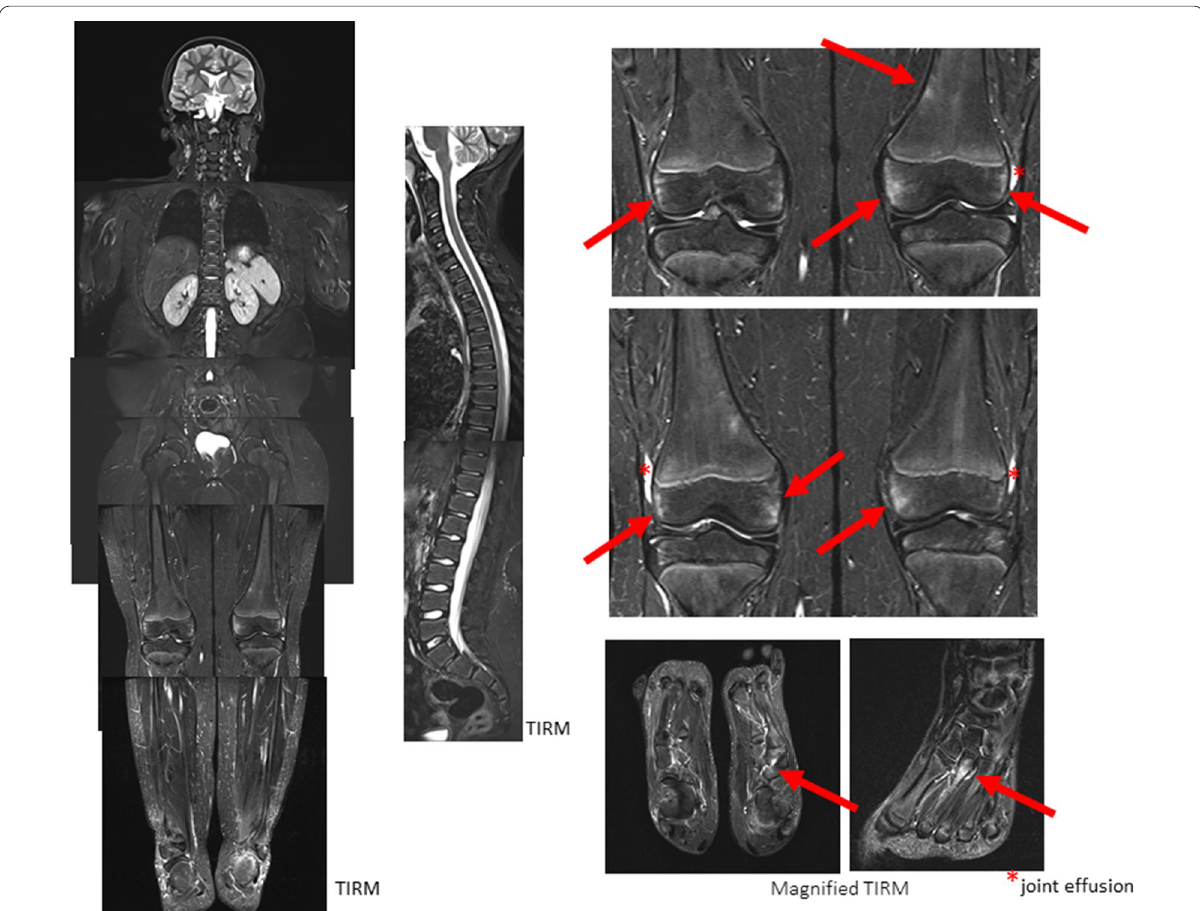
Fig. 3 An 11-year-old boy also without previous history of MSK pathologies and pain at multiple body regions (lower extremities, especially knees and feet). MRI shows bone marrow edema—more subtle than in Fig. 1, affecting the long bones (with focus on epiphyseal and metaphyseal areas) and